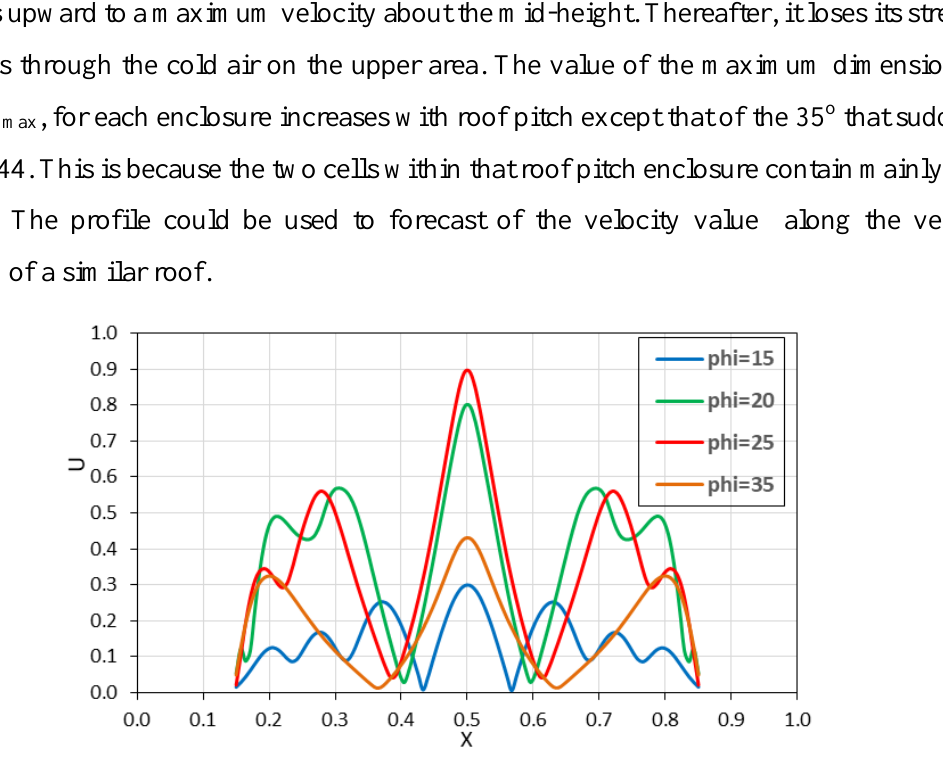
Fig. 6. Velocity along horizontal line at Y= 0.5H of the roof pitch